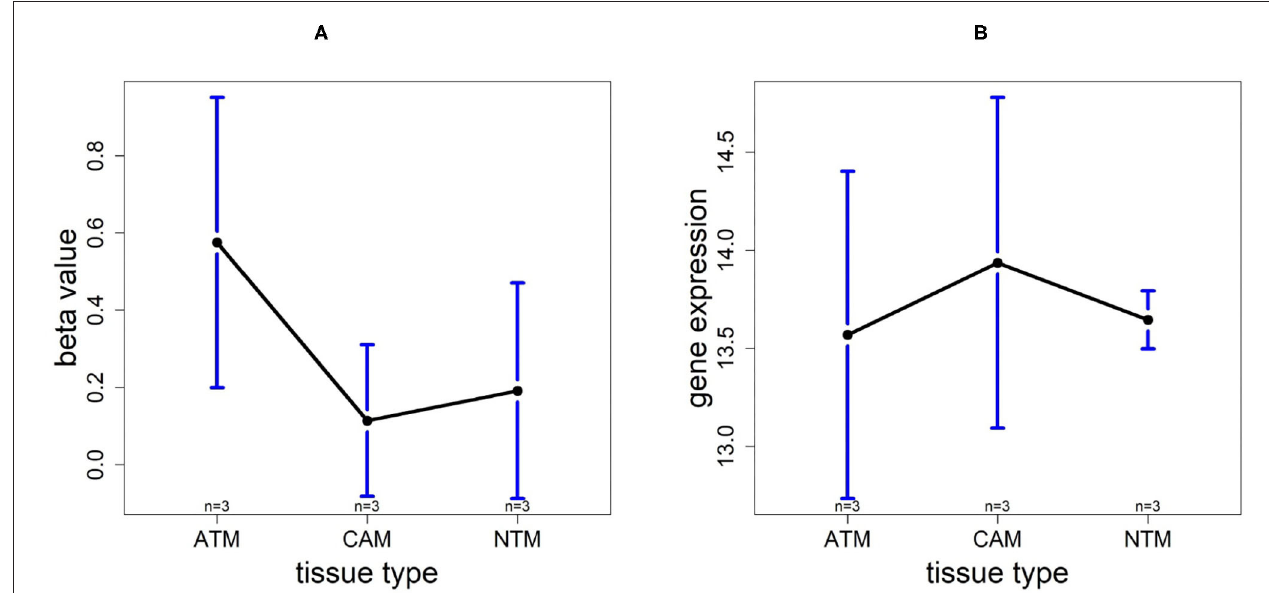
FIGURE 12 | The overall methylation and gene expression levels of the UCHL1 promoter region. (A) Averaged methylation level over the three samples of gene UCHL1 among tissue types from GSE97686 dataset. (B) Averaged gene expression level over the three samples of gene UCHL1 among tissue types from GSE107161 dataset. The blue bars represent 95% confidence intervals. Some error bars are large as the sample size is only 3 in each tissue type.